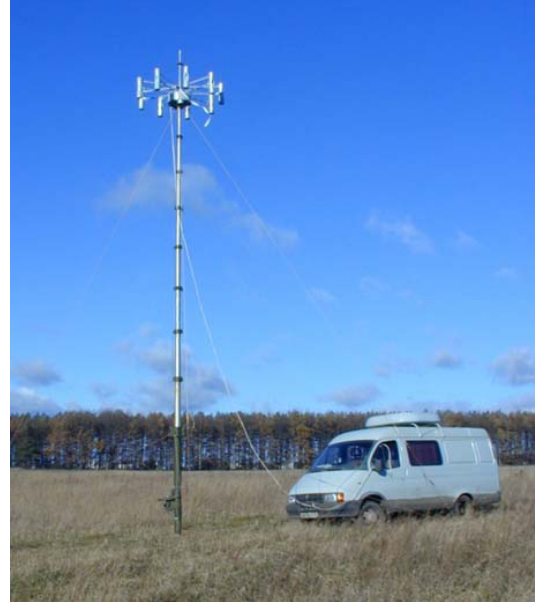
Figure 16. The ARK-MK1M radio monitoring complex with an additional antenna and radio receiving system ARK-MK4 on a telescopic mast.